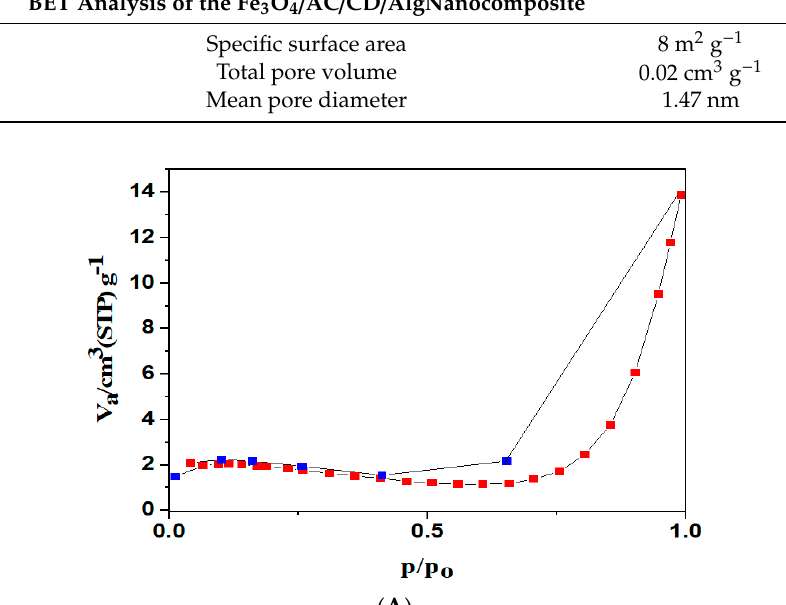
Table 2. Textural properties of the Fe 3 O 4 /AC/CD/Alg nanocomposite. BET Analysis of the Fe 3 O 4 /AC/CD/AlgNanocomposite